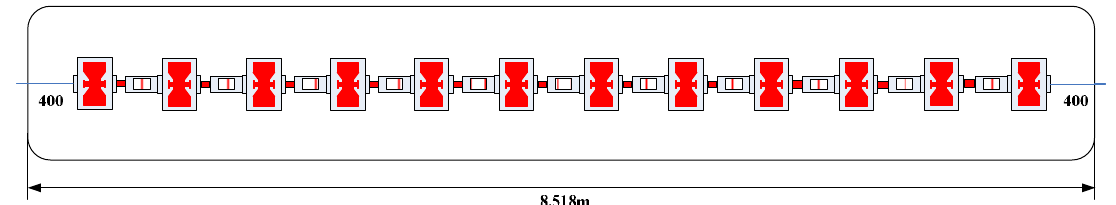
FIG. 12. Schematic of the Spoke012 lattice with one